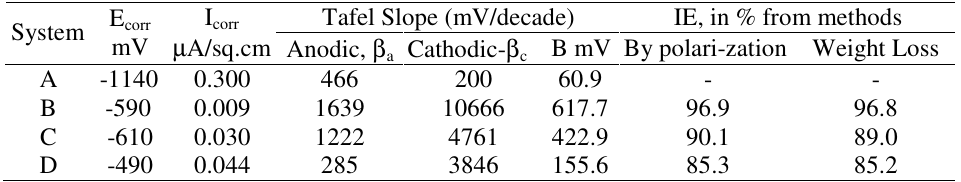
Table 3. Polarization data and Inhibition efficiency (IE%) of ethanolamines for zinc in